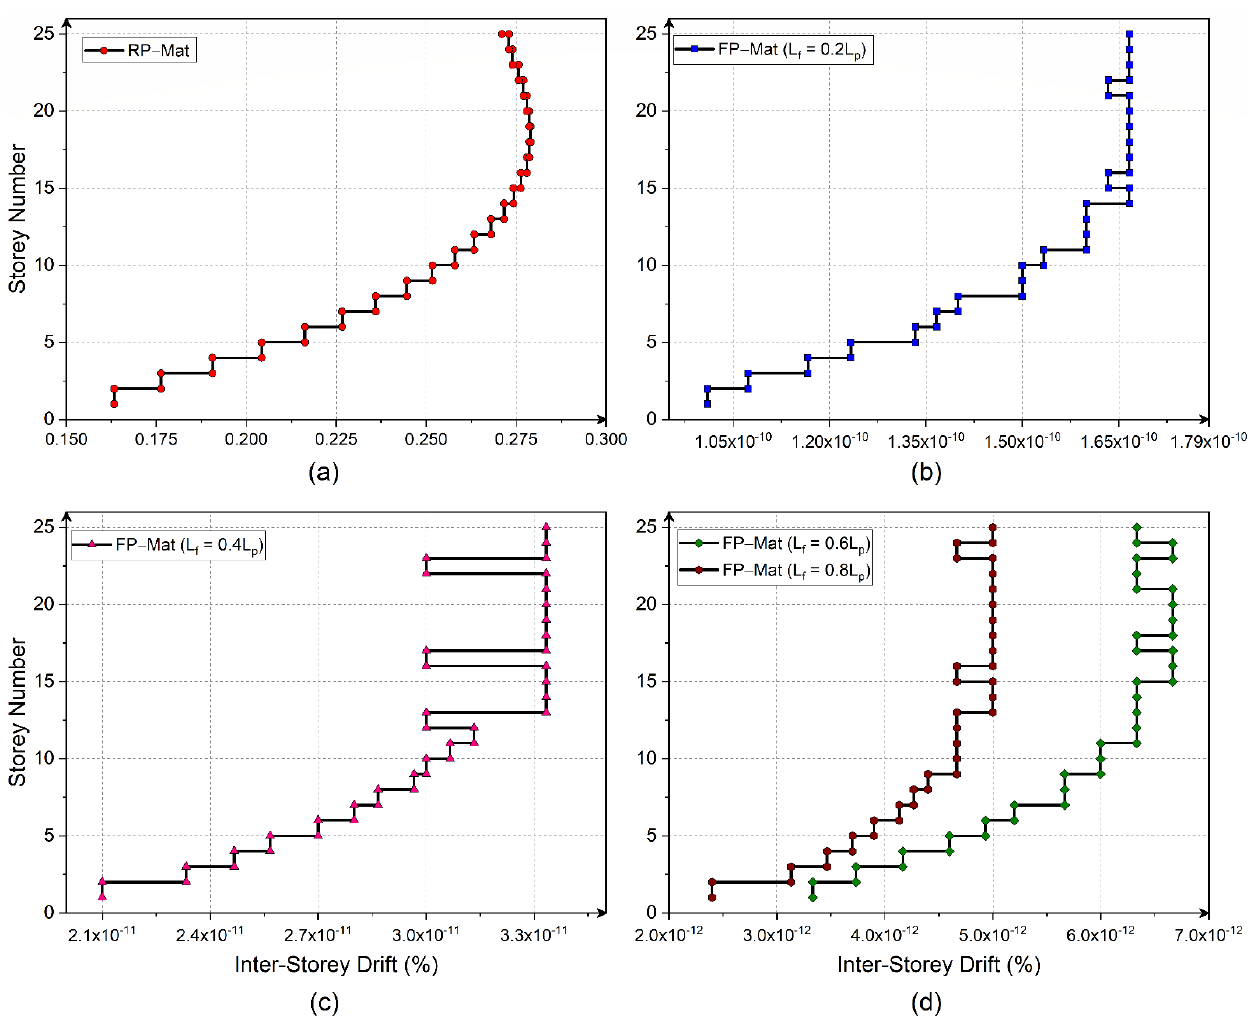
Figure 14. Variation in the inter-story drifts for buildings resting on various piled-mats: ( a ) RP-Mat; ( b ) FP-Mat with L f = 0.2L p ; ( c ) FP-Mat with L f = 0.4L p ; and ( d ) FP-Mats with L f = 0.6L p , 0.8L p .